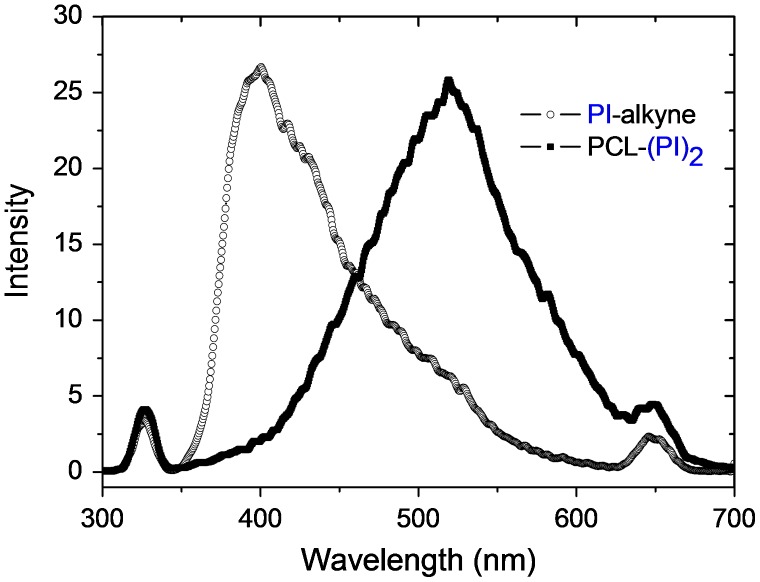
Fluorescence spectra of PI-alkyne (1.60 × 10−2 mol L−1) and PCL-(PI)2 (4.00 g L−1) in CH2Cl2, λ
exc = 325 nm.